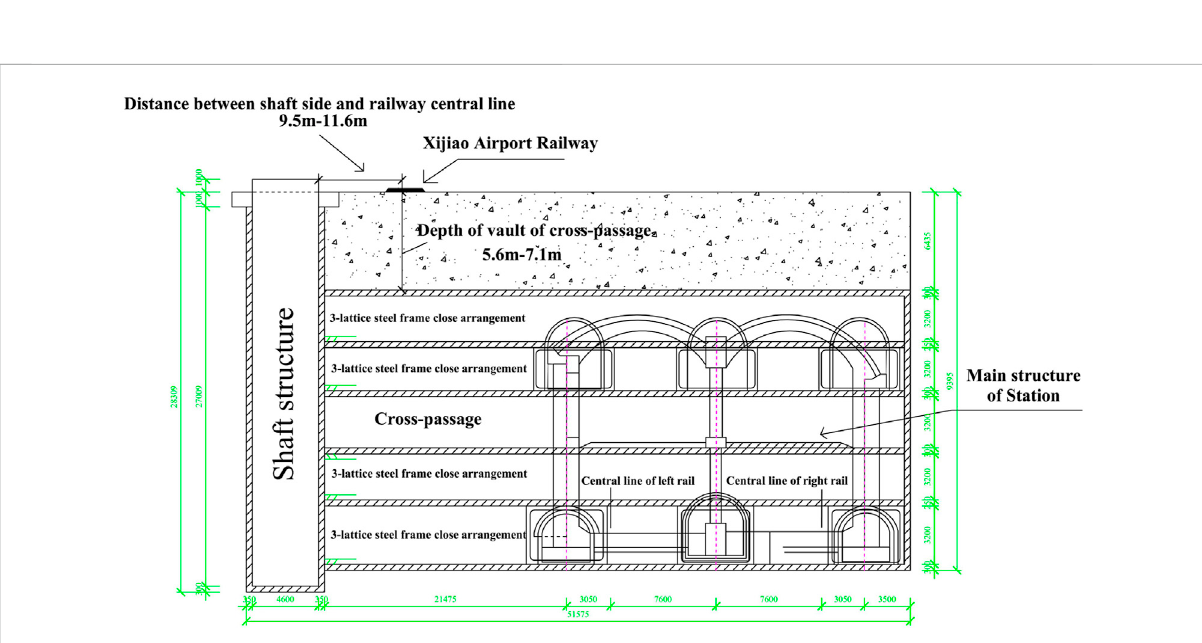
FIGURE 2 Relationship between the new structure and existing railway